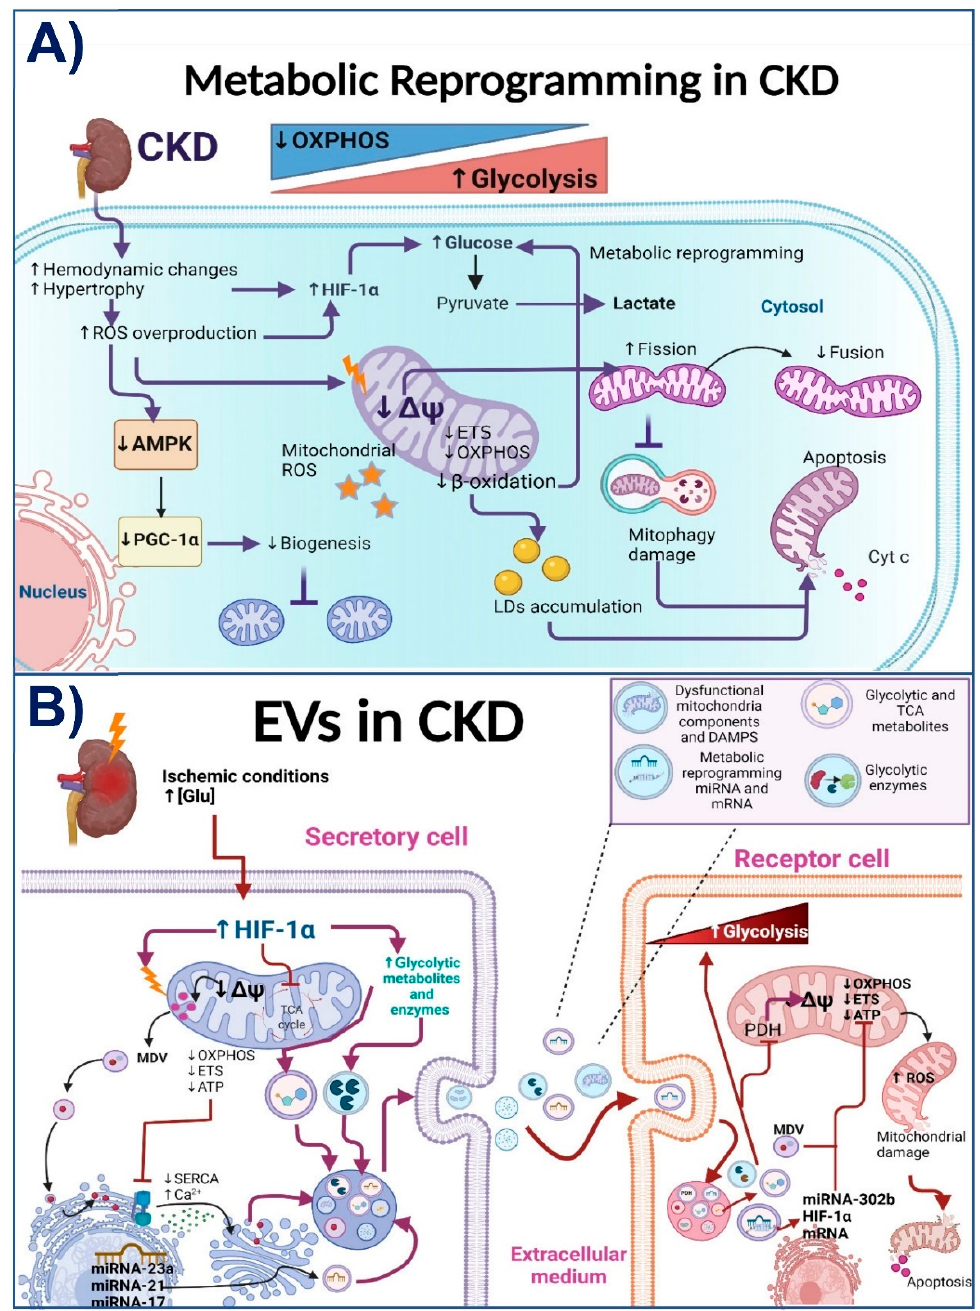
Figure 2. ( A ) Metabolic reprogramming in chronic kidney disease (CKD) in tubular epithelial cells. CKD is characterized by a gradual and progressive shift of energy metabolism from oxidative phosphorylation system (OXPHOS) to glycolysis in the kidney. CKD triggers pathological mecha- nisms such as hemodynamic changes and hypertrophy. This, together with the reactive oxygen species (ROS) overproduction, favors the activation of hypoxia-inducible factor 1-alpha (HIF-1 α ), enhancing glycolytic flux and the accumulation of glycolytic metabolites such as pyruvate. Addi- tionally, ROS overproduction decreases protein levels and activation of AMP-activated protein kinase (AMPK) and peroxisome proliferator-activated receptor-gamma coactivator 1-alpha (PGC-1 α ), reducing mitochondrial biogenesis in the kidney. The mitochondrial impairment in- duced in CKD is characterized by a decrease in the activity of the electron transport system (ETS) and OXPHOS, which reduces ATP production by decreasing mitochondrial membrane potential ( ↓ ΔΨ m). The ΔΨ m drop and the oxidative stress in this organelle trigger mitochondrial fragmen- tation by fission-induction and the subsequent recruitment of the mitophagy machinery. However, the impairment in autophagy flux together with the accumulation of lipid droplets (LDs) derived